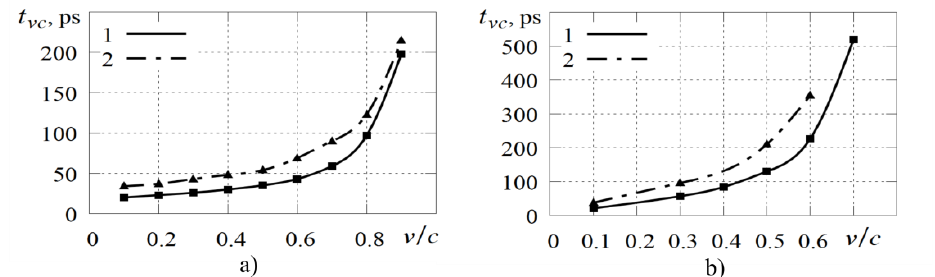
Fig. 7. The virtual cathode formation time a) at constant space charge density b) at constant current of 1 kA at speed of 0.8 c and the initial beam geometry. 1 - with images, 2 - without